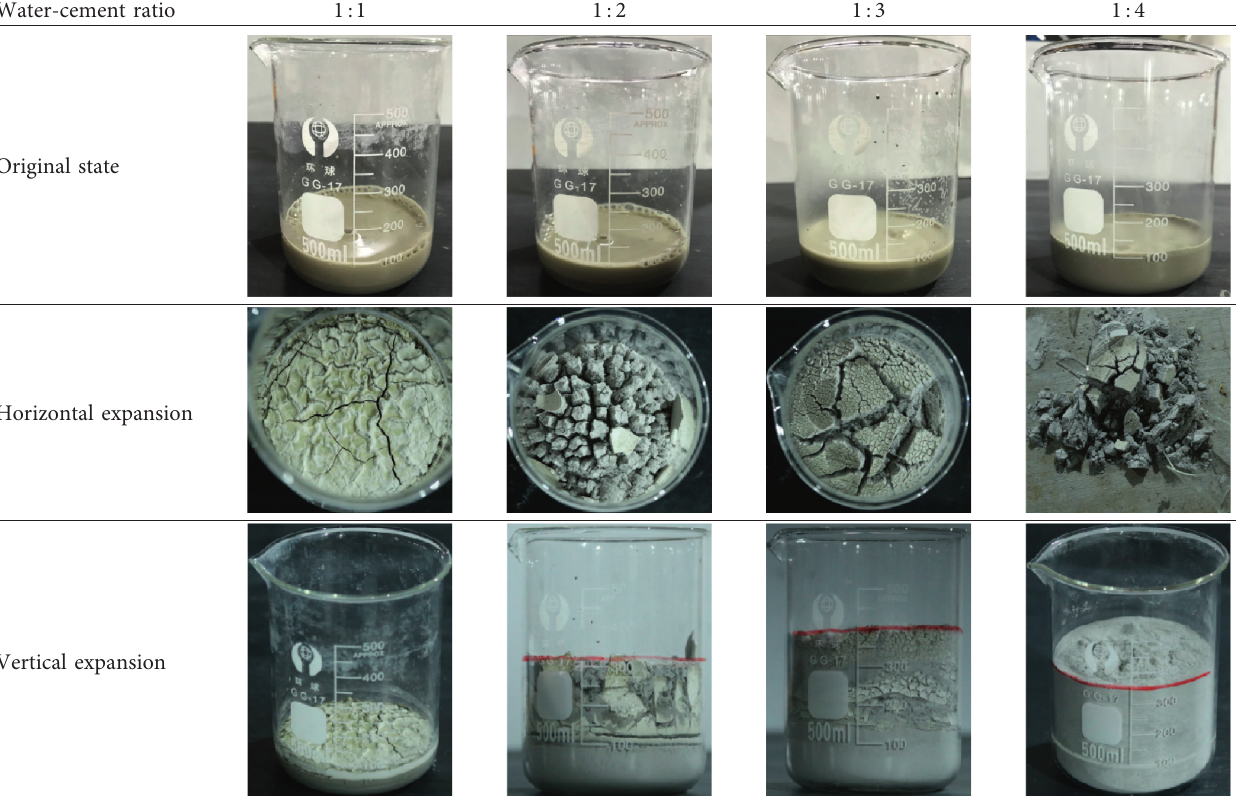
Table 2: Expansion characteristics of expansive agent with different water-cement ratios. Water-cement